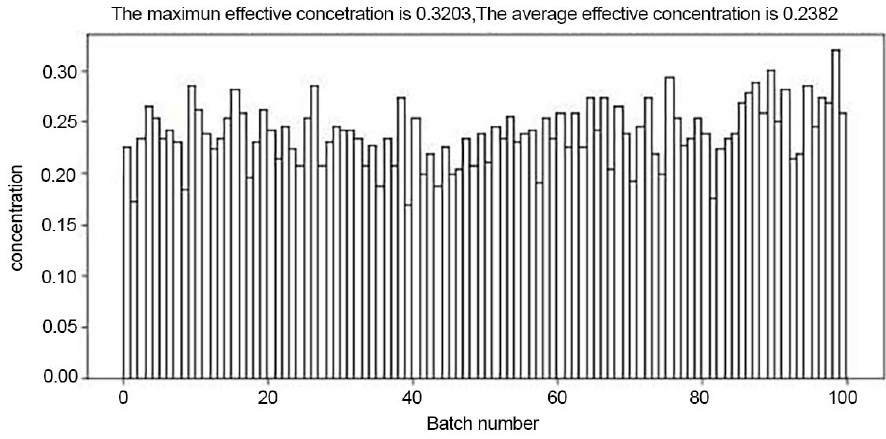
Figure 8. Histogram of batch number and concentration.